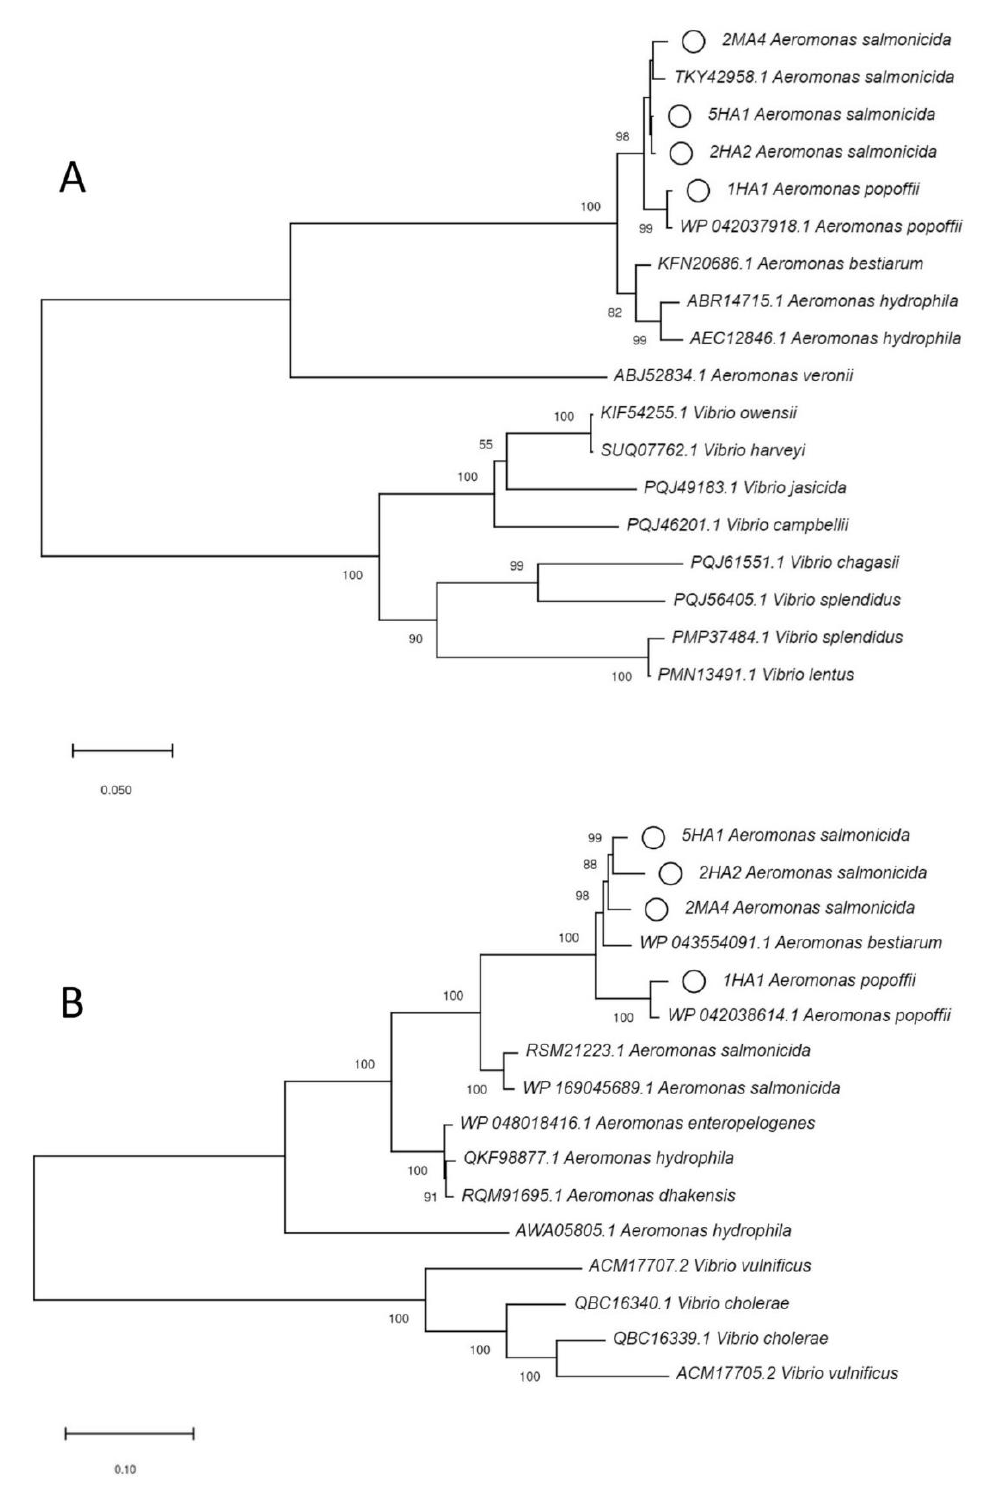
Figure 2. ( A ) Phylogenetic tree of AerA based on amino acid sequences. ( B ) Phylogenetic tree of RtxA based on amino acid sequences. The proteins highlighted with small circles are found in A. salmonicida isolates in this study. Accession numbers and host organisms are presented for sequences downloaded from GenBank. Numbers at nodes are bootstrap values (%) based on 1000 resampled datasets; only values > 50% are